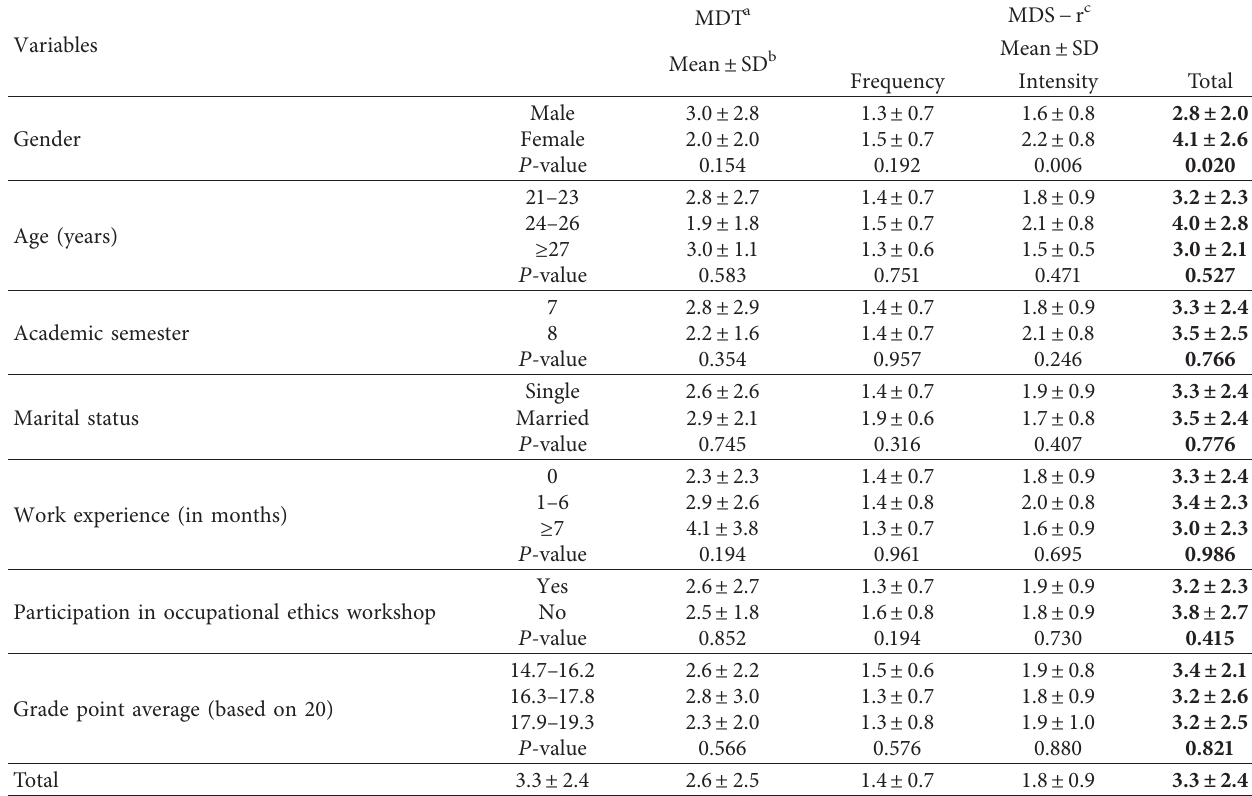
Table 2: The level of moral distress in terms of demographic characteristic of